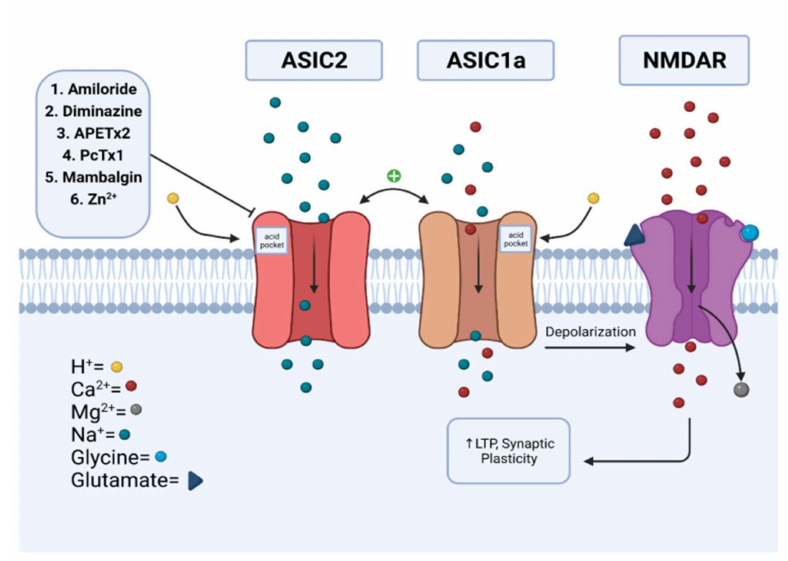
Figure 2. Synaptic role of ASIC2 in promoting LTP and synaptic plasticity. ASIC2 both upregulates and forms complexes with ASIC1a and plays a role in membrane depolarization and NMDAR activation. Also depicted are the molecules reviewed in this paper which modulate ASIC2 channels. Listed are modulators of 1–6; each of these modulate ASIC2 channels through various mechanisms and lead to altered sodium and/or calcium influx. The labeled protons excite the subunit complexes. NMDAR: N -methyl- D -aspartate receptor. LTP: long-term potentiation. Adapted from “Transporters” by BioRender.com (2021). Retrieved from https://app.biorender.com/biorender-templates, accessed on 1 December